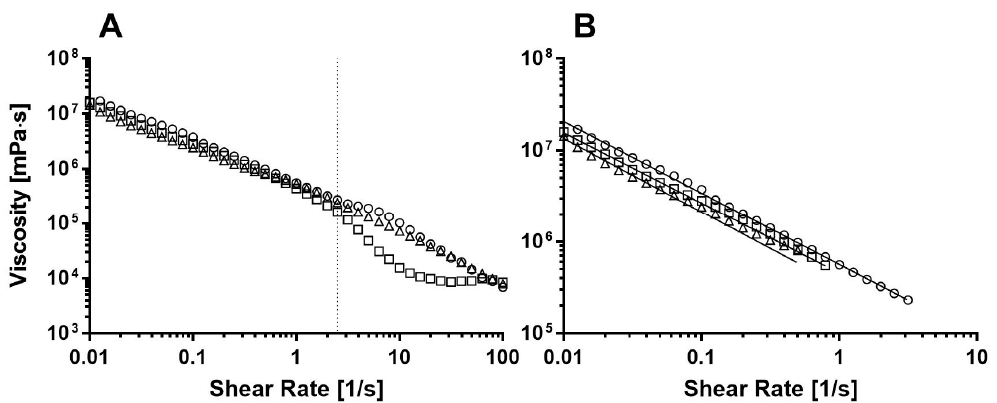
Figure 6. Typical flow obtained for ( A ) different bigel formulations; H1 ( о ), H2 ( ∆ ), and H6 ( □ ), and the ( B ) linear regression of the log-log plot at intermediate shear rates.